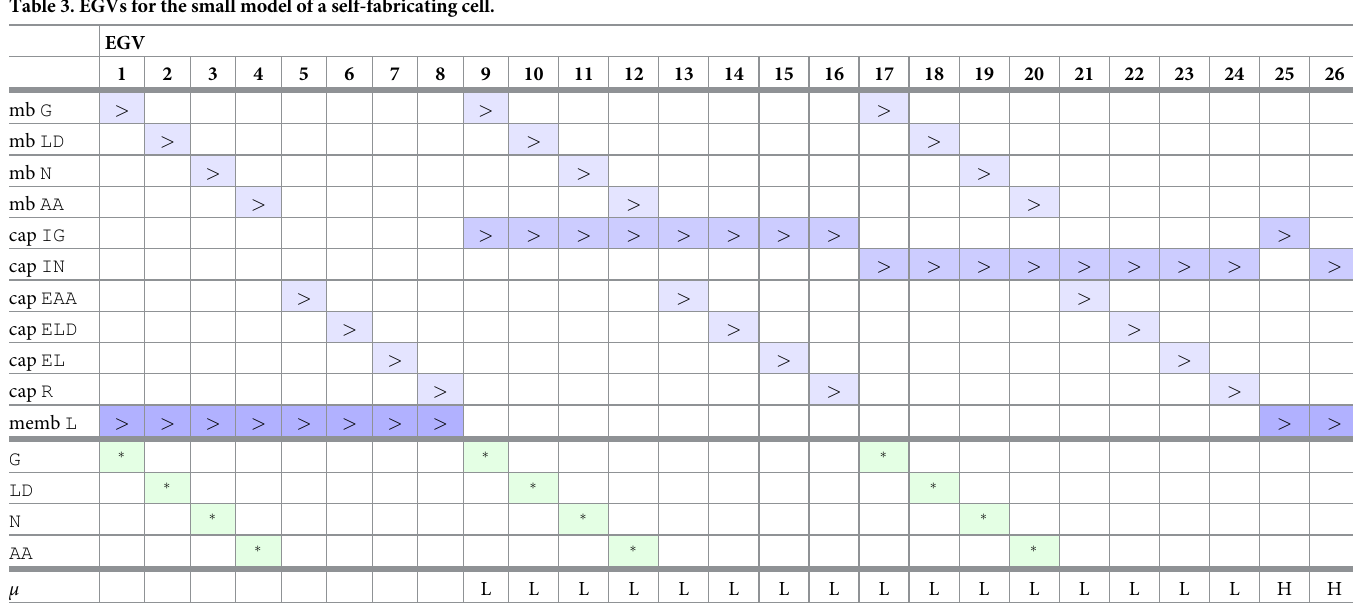
There are 26 EGVs. Every EGV is characterized by its set of inactive inequality constraints. For every EGV, two constraints are inactive (that is, fulfilled with > ), and all other constraints are active (fulfilled with =). For the list of inequality constraints, see Table A in S1 Text. Further, for every EGV, at most one of the associated concentrations of the metabolites { G , LD , N , AA } is nonzero ( � ). Finally, EGVs 1–8 exist for all growth rates, whereas EGVs 9–24 exist for low (L) growth rates and EGVs 25, 26 exist for high (H) growth rates. At the critical growth rate, EGVs 9–16 merge into EGV 25, and EGVs 17–24 merge into EGV 26.